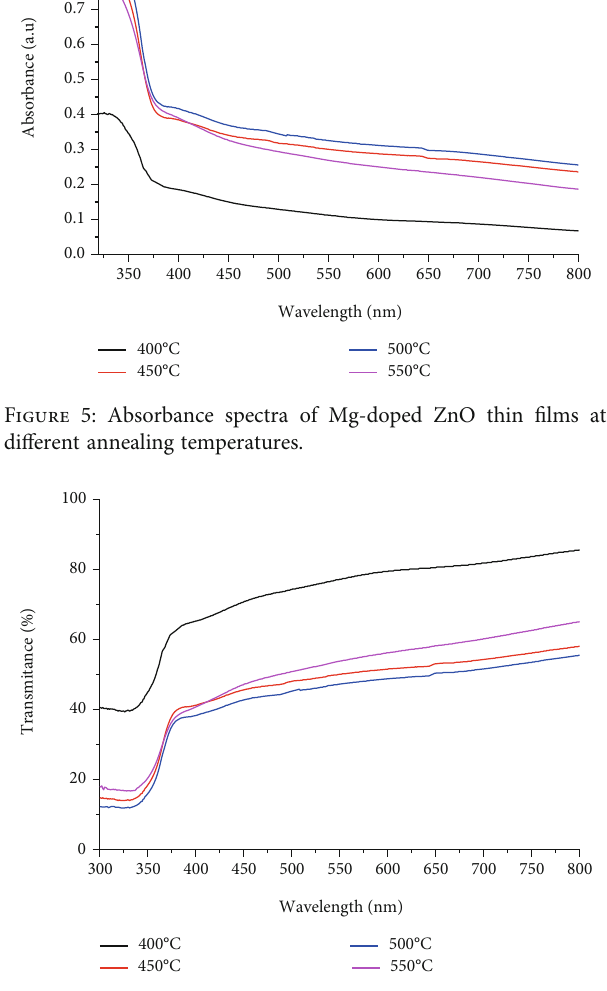
Figure 6: Transmittance spectrum of Mg-doped ZnO thin fi lms at di ff erent annealing temperatures.